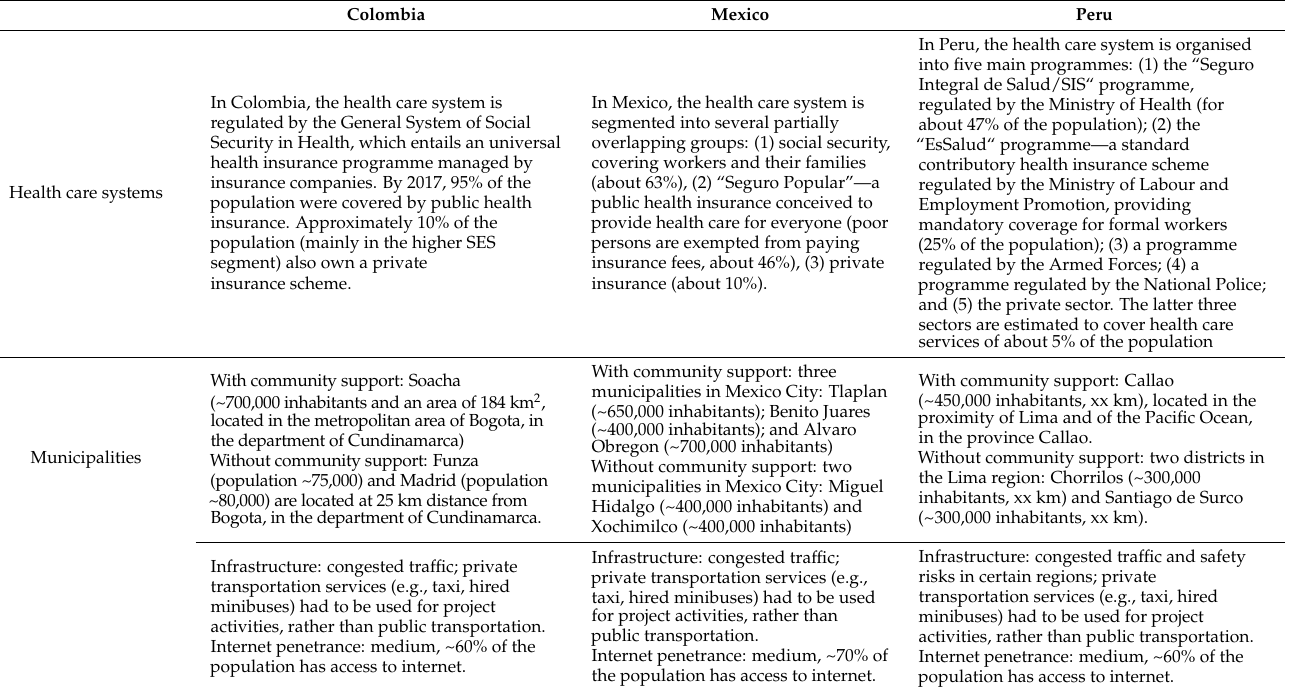
Table A1. Description of the health care systems and participating municipalities in the three